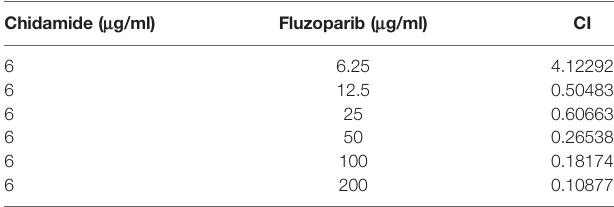
TABLE 2 | The combination index of different doses of fl uzoparib and 3 m g/ml chidamide: HCC1937-FR. Chidamide ( m g/ml)